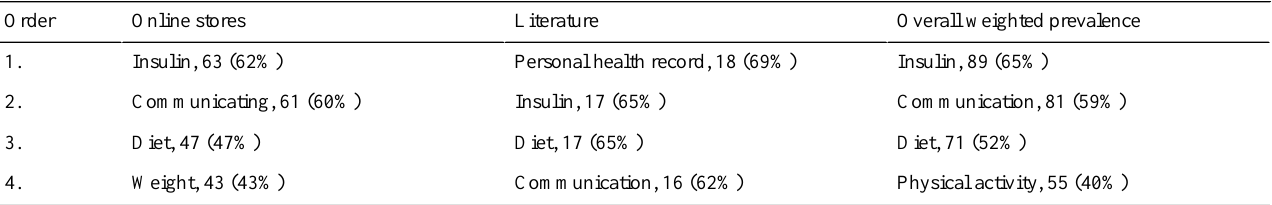
Table 2. The most prevalent features (n = 137 applications) on the online markets versus in the literature